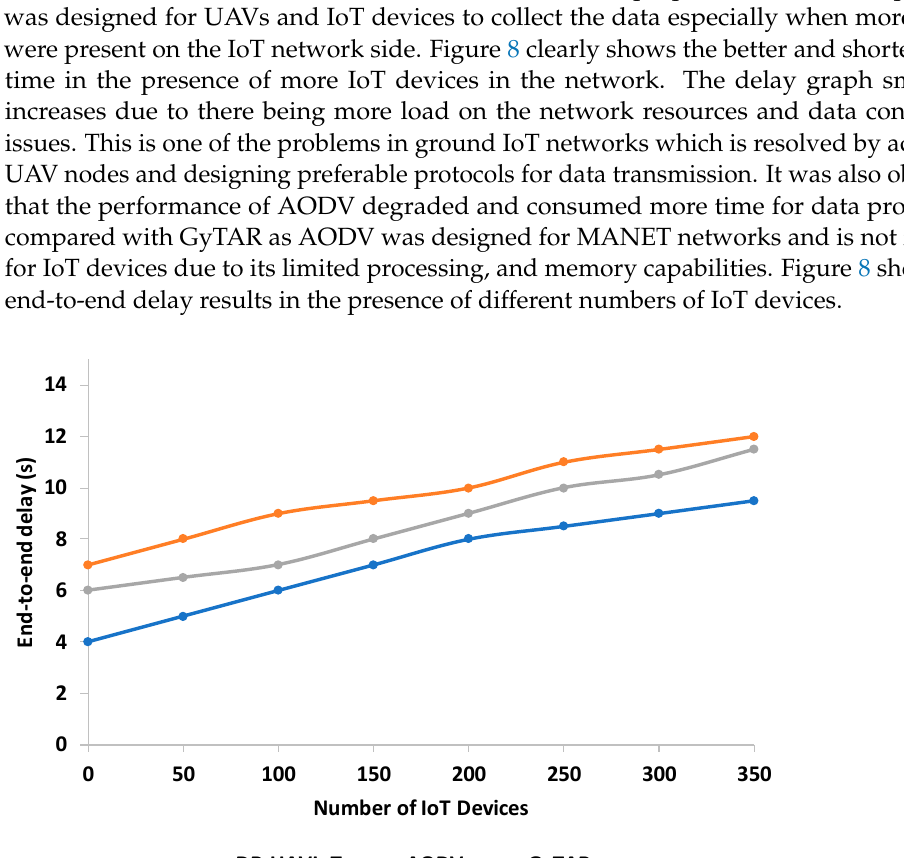
Figure 7. Packet Delivery Ratio in the Presence of Different UAVs Nodes Velocity.